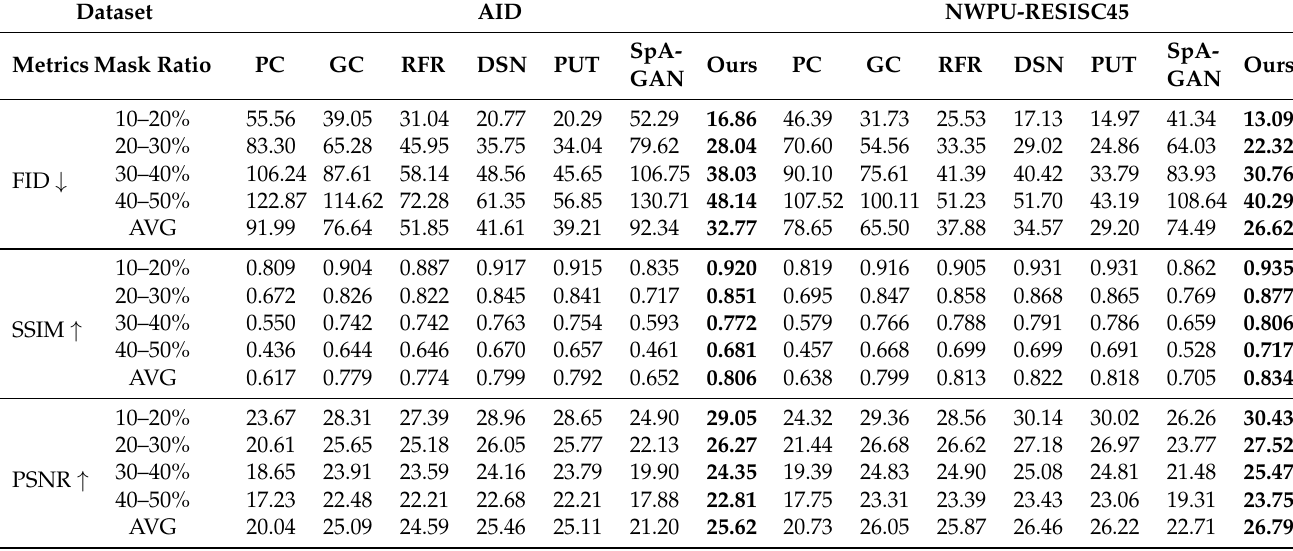
Table 1. Numerical comparison of the AID and NWPU-RESISC45 datasets.